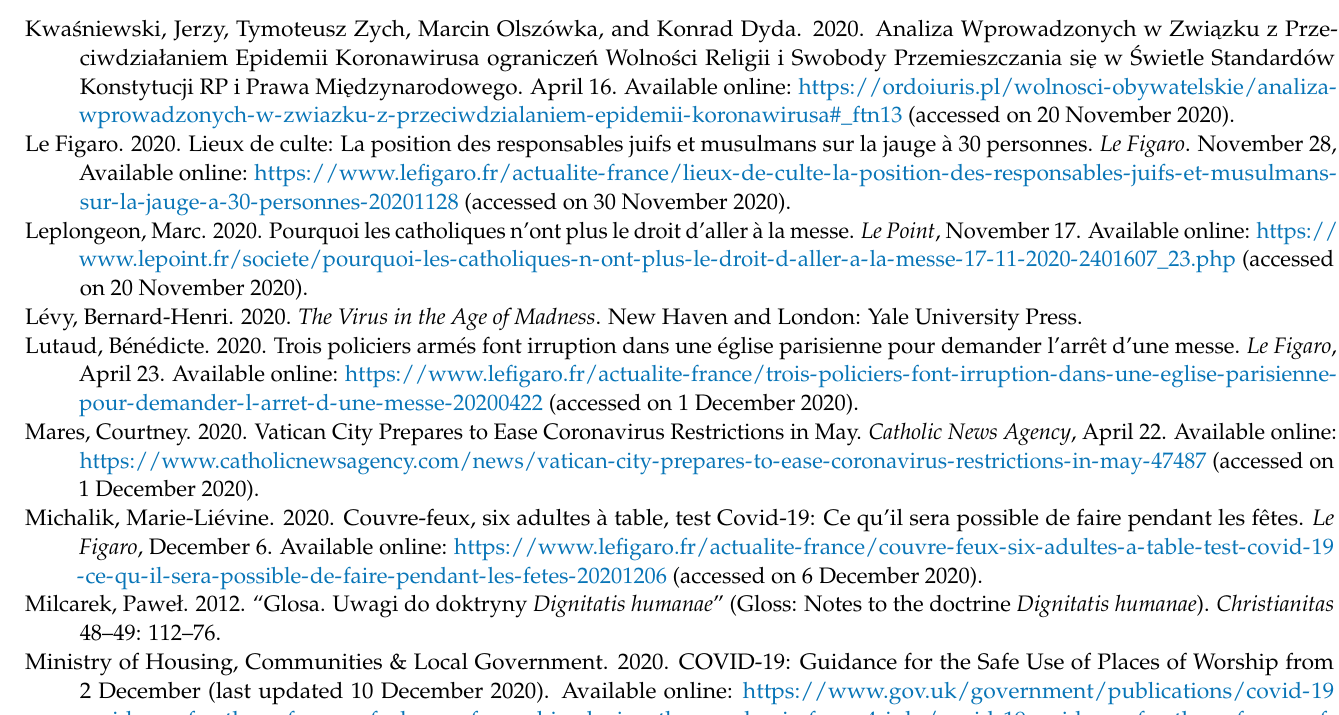
Figaro , December 6. Available online: